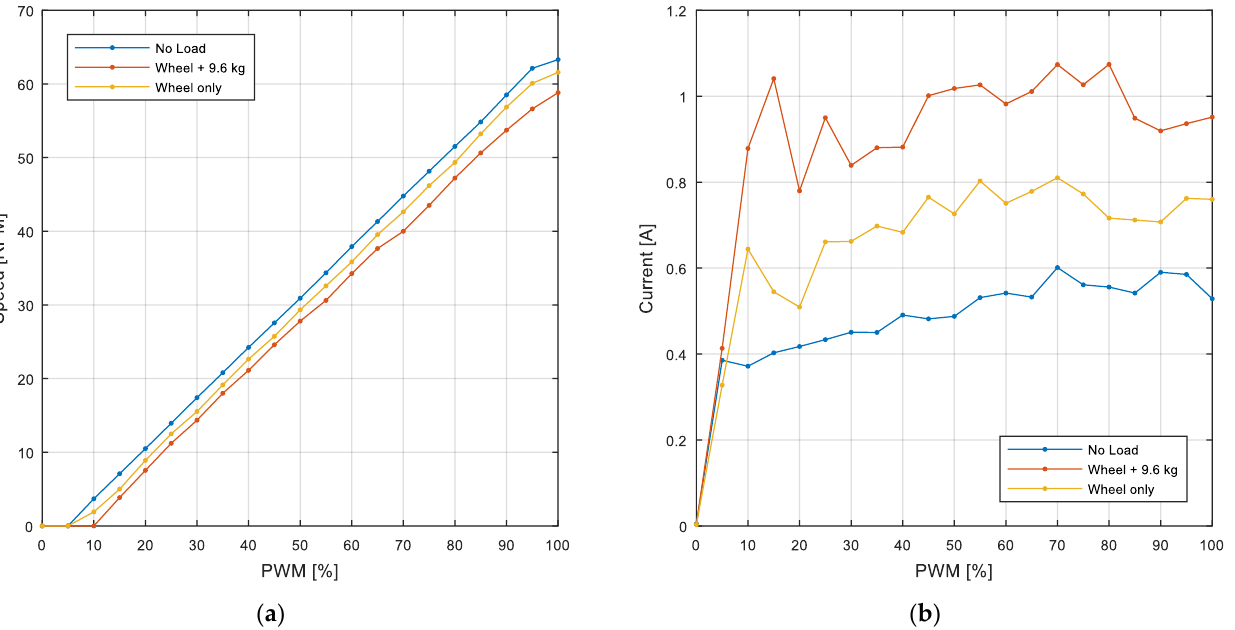
Figure 9. ( a ) PWM and RPM relationship in different load scenarios. ( b ) Motor current consumption depending on the applied PWM duty cycle in different load scenarios.